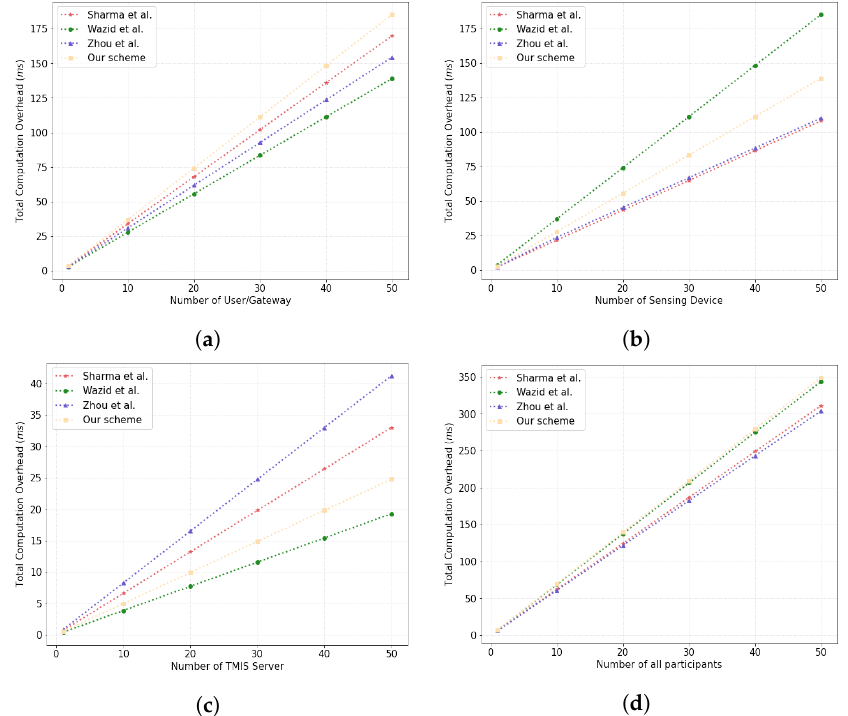
Figure 5. Computation overhead comparison of ( a ) users, ( b ) sensing devices, ( c ) TMIS servers, and ( d ) all participants [20–22].